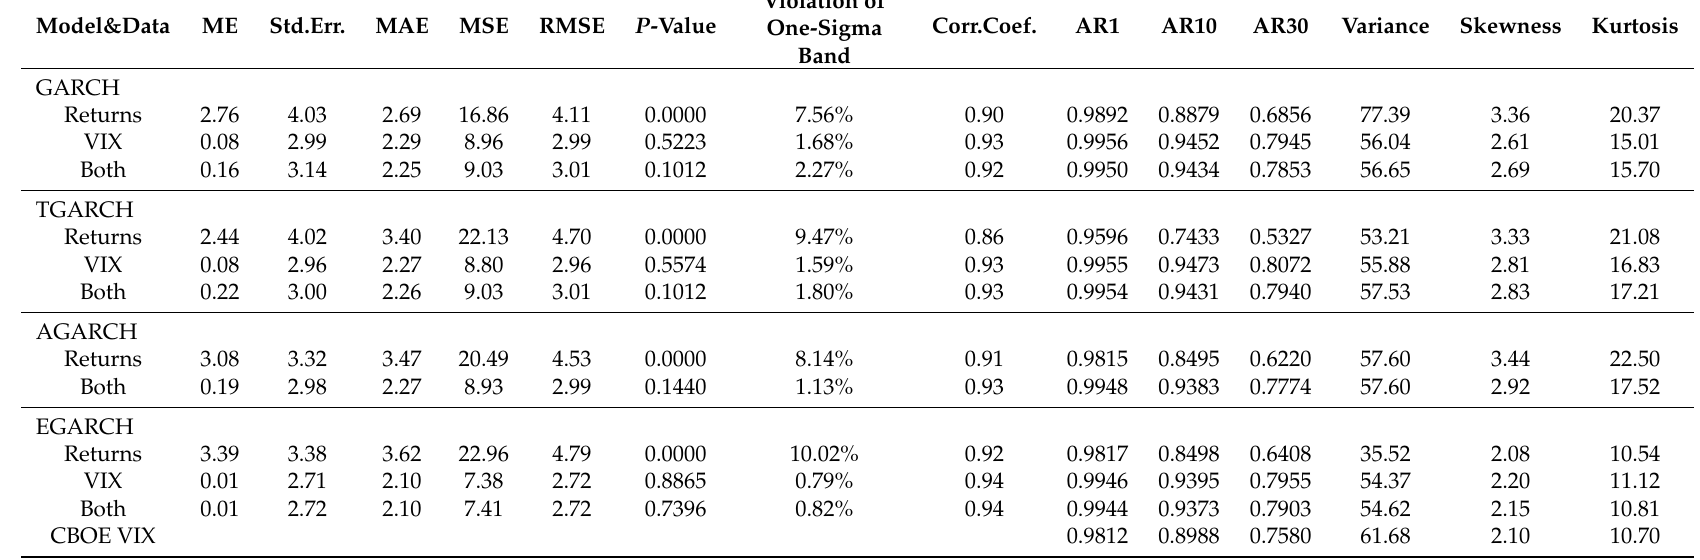
Table 5. The table displays the related statistics between the model implied VIX and the CBOE VIX for the GARCH models during the period from 2 January 1990 to 30 June 2017. We use the sample of 6928 daily data for the model estimation and comparison. The error is computed as the difference between CBOE VIX and the implied VIX. The mean error (ME) represents the mean daily difference between the implied VIX and the CBOE VIX. The standard error (Std.Err.) represents the standard deviation of the error. The mean absolute error (MAE) calculates the mean daily absolute difference between the implied VIX and the CBOE VIX. The mean squared error (MSE) computes the mean daily squared difference between the implied VIX and the CBOE VIX. The root mean squared error (RMSE) computes the square root of the mean squared error. The P -value is for the null hypothesis that the implied VIX and the CBOE VIX have the same mean values. Violation of one-sigma band stands for the probability that the implied VIX lies out of the one-standard-deviation band of the CBOE VIX. The correlation coefficient